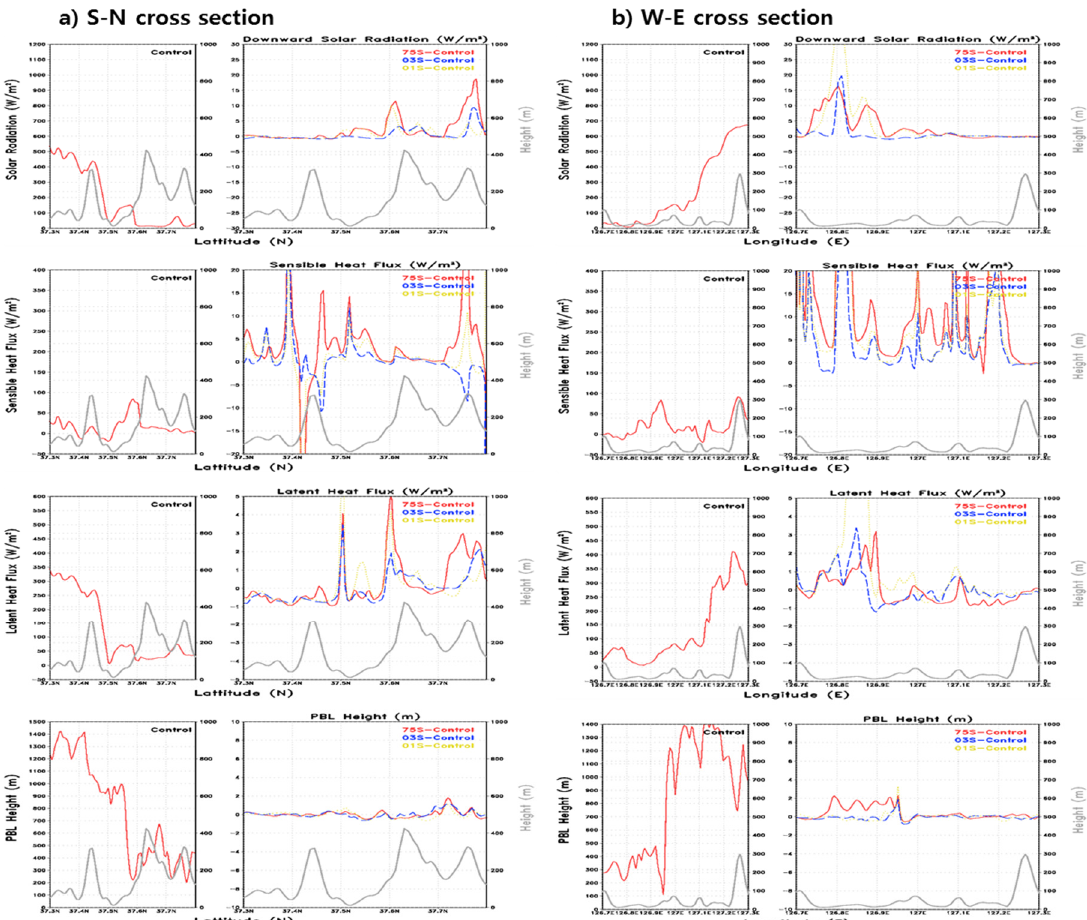
Figure 11. Relative difference of simulations relative to Control for 75S (red solid line), 03S (blue dashed line), and 01S (yellow dotted line). ( a ) South–north and ( b ) East–west cross sections on 37.55°N for (1st row) global shortwave radiation, (2nd row) sensible heat flux, (3rd row) latent heat flux, and (4th row) planetary boundary layer height at 1600LST. The light gray line represents topographical height along the sections shown in Figure 1d. In the left window of each panel, the red lines represent the variables in the control run.